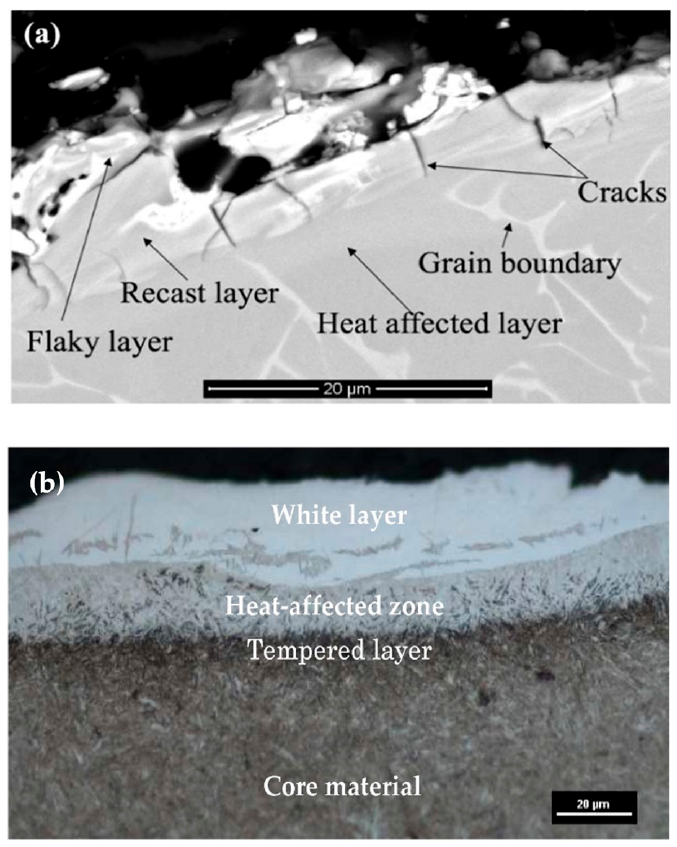
Figure 2. The layers formed over ( a ) Ti-6Al-4V [14] and ( b ) 55NiCrMoV7 [15] after EDM processing. (With kind permission from the respective publications).